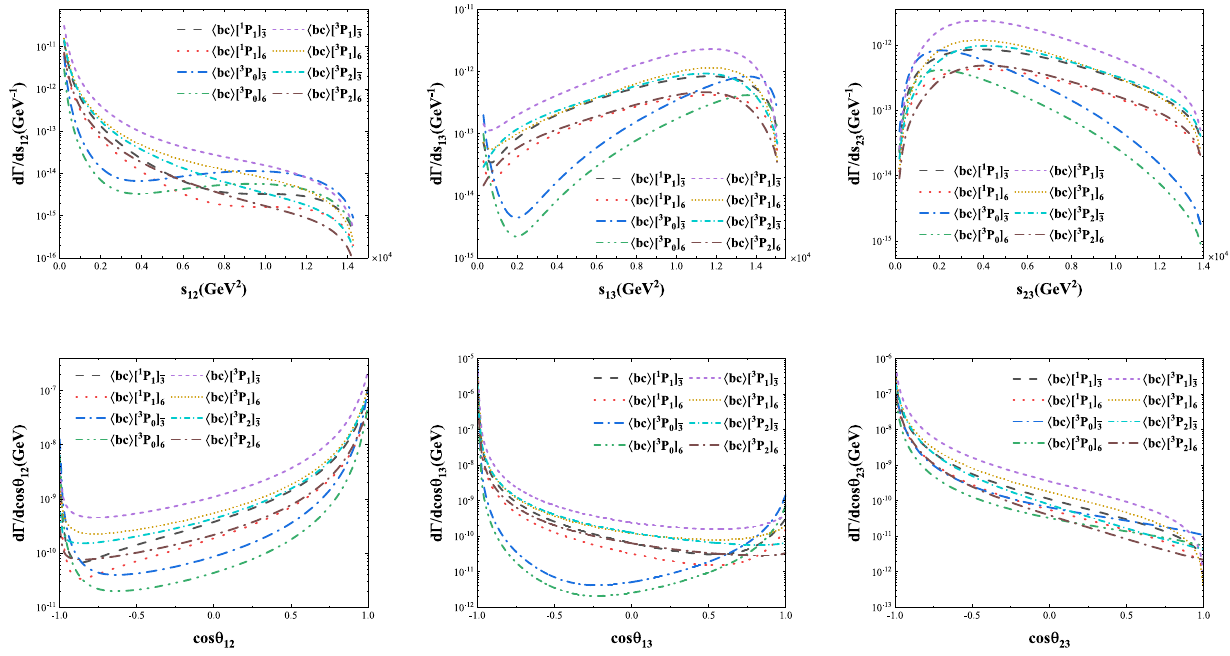
) + ¯ b ( p ) . Eight colorful lines represent the considered interme- ¯ c ( p 2 3 diate diquark states, i.e., (cid:3) bc (cid:5)[ 1 P 1 ] ¯ and (cid:3) bc (cid:5)[ 3 P J ] ¯ with J =0, 1, 3 / 6 3 / 6